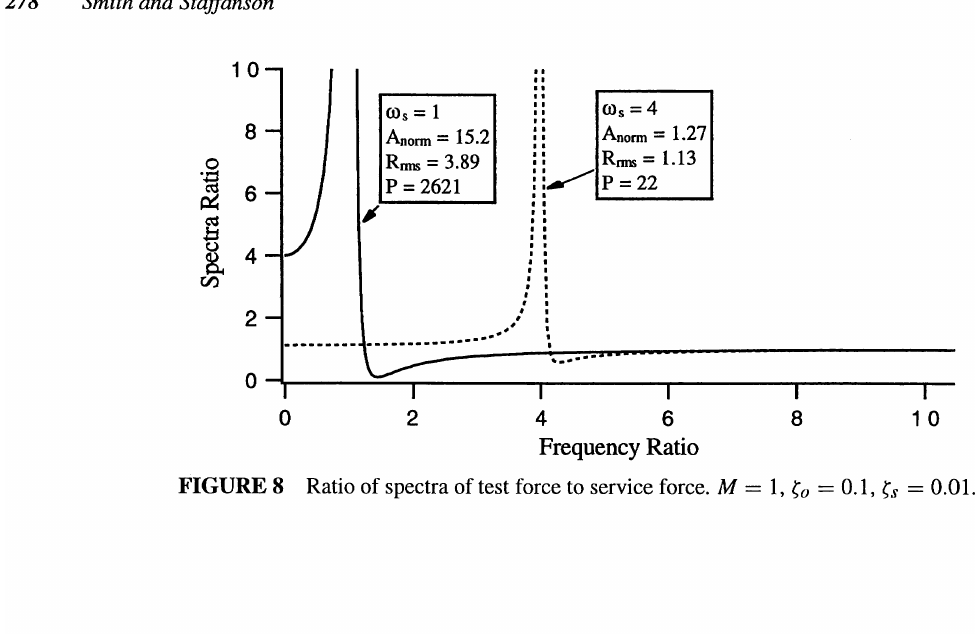
FIGURE 8 Ratio of spectra of test force to service force. M = 1, (0 = 0.1, (s = 0.01.